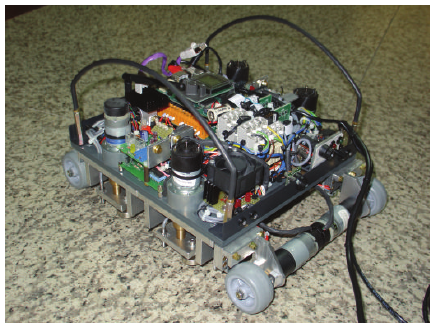
Figure 1: Photo of the final prototype of the developed climbing robot with locomotion through wheels and adhesion with perma- nent